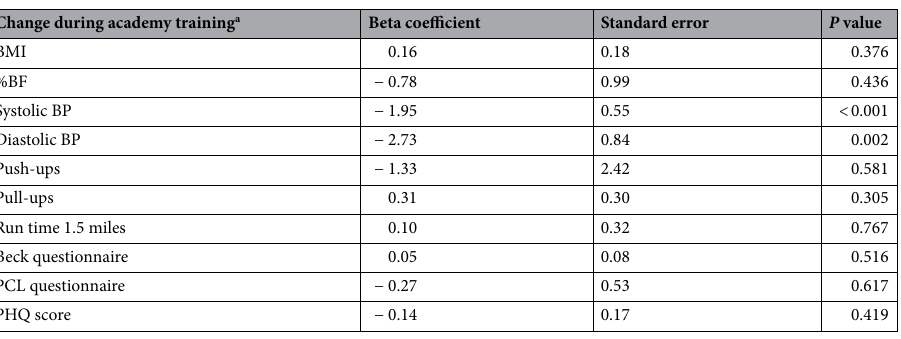
Table 4. Multivariable adjusted changes in selected health profiles per 1-point MEDI-lifestyle score increment during academy training among the whole fire recruit cohort (N = 129). Statistics derived from age, sex, baseline %BF, baseline push-ups, baseline Beck score, and academy class adjusted linear regression models. BMI, %BF, blood pressures, push-ups, pull-ups, run time, and MEDI-lifestyle score are only available for one academy of the intervention group (n = 37), leaving a total of 129 recruits (37 from the intervention group and 92 from the historical control group) for the analyses. BMI body mass index, %BF percent body fat, BP blood pressure, Beck Beck depression inventory for primary care, PCL post-traumatic stress disorder (PTSD) questionnaire, PHQ patient health questionnaire. a Absolute number changes for pull-ups, Beck, PCL, and PHQ. Percent changes for other